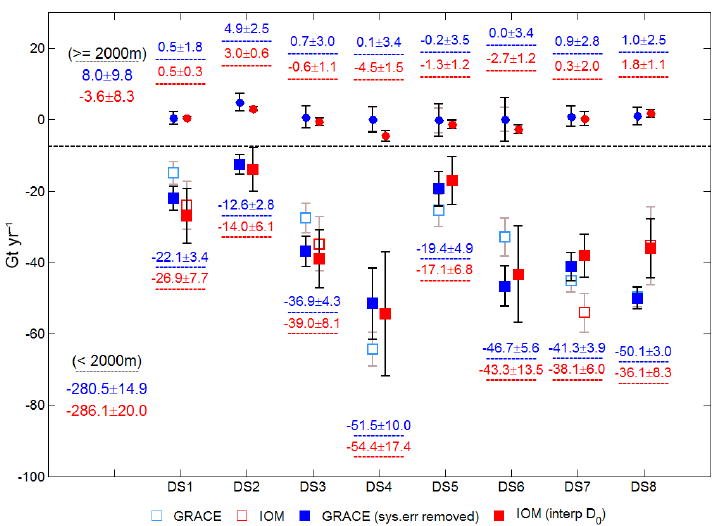
Figure 5. Comparison of the 2003 to 2013 regional mass change rates between the GRACE solution and the IOM solutions. The first column on the left refers to the entire GrIS and the following ones to the right indicate the complete drainage area according to Zwally et al. (2012). The regional mass change rates from GRACE before correcting for the approximation error are represented by the light blue hollow squares; the filled dark blue squares indicate the mass change rates after implementing the correction. The numbers show the mass change rates in blue and red color which indicate the GRACE solution and IOM solution, respectively. The dashed line separates the solutions from the interior regions (above the dashed line) and from the coastal regions (below the dashed line). The error bars are estimated in Sect.